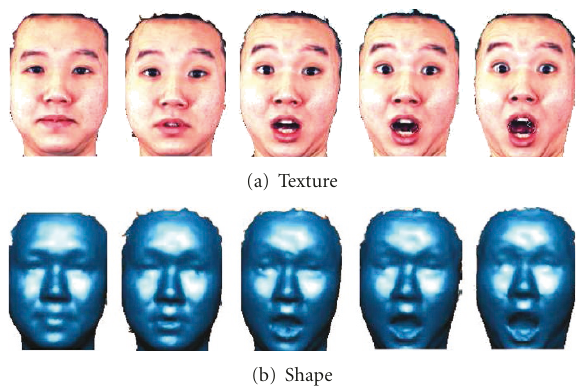
Figure 12: An example of the dynamic 3D face sequence.